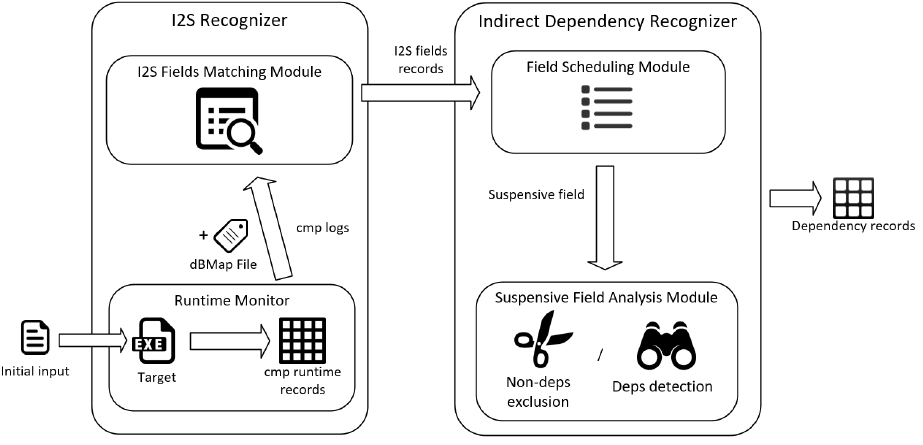
Figure 6. The overview of FFAFuzz with de Bruijn-based